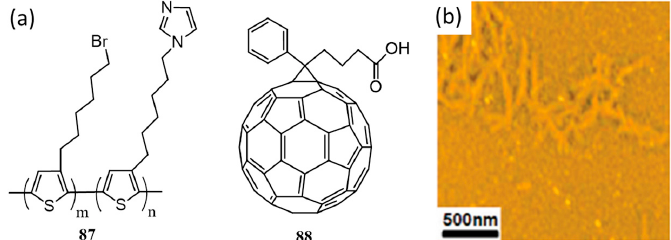
Figure 29. ( a ) Chemical structure of 87 and 88 synthesized by Chen et al. [97] ( b ) Tapping-mode AFM topographic image obtained from the surfaces of 87 / 88 (1:0.8 w / w ) films prepared as-spun using CB/MeOH (49:1) as a solvent. Adapted with permission from Ref. [97] Copyright 2012 American Chemical Society.